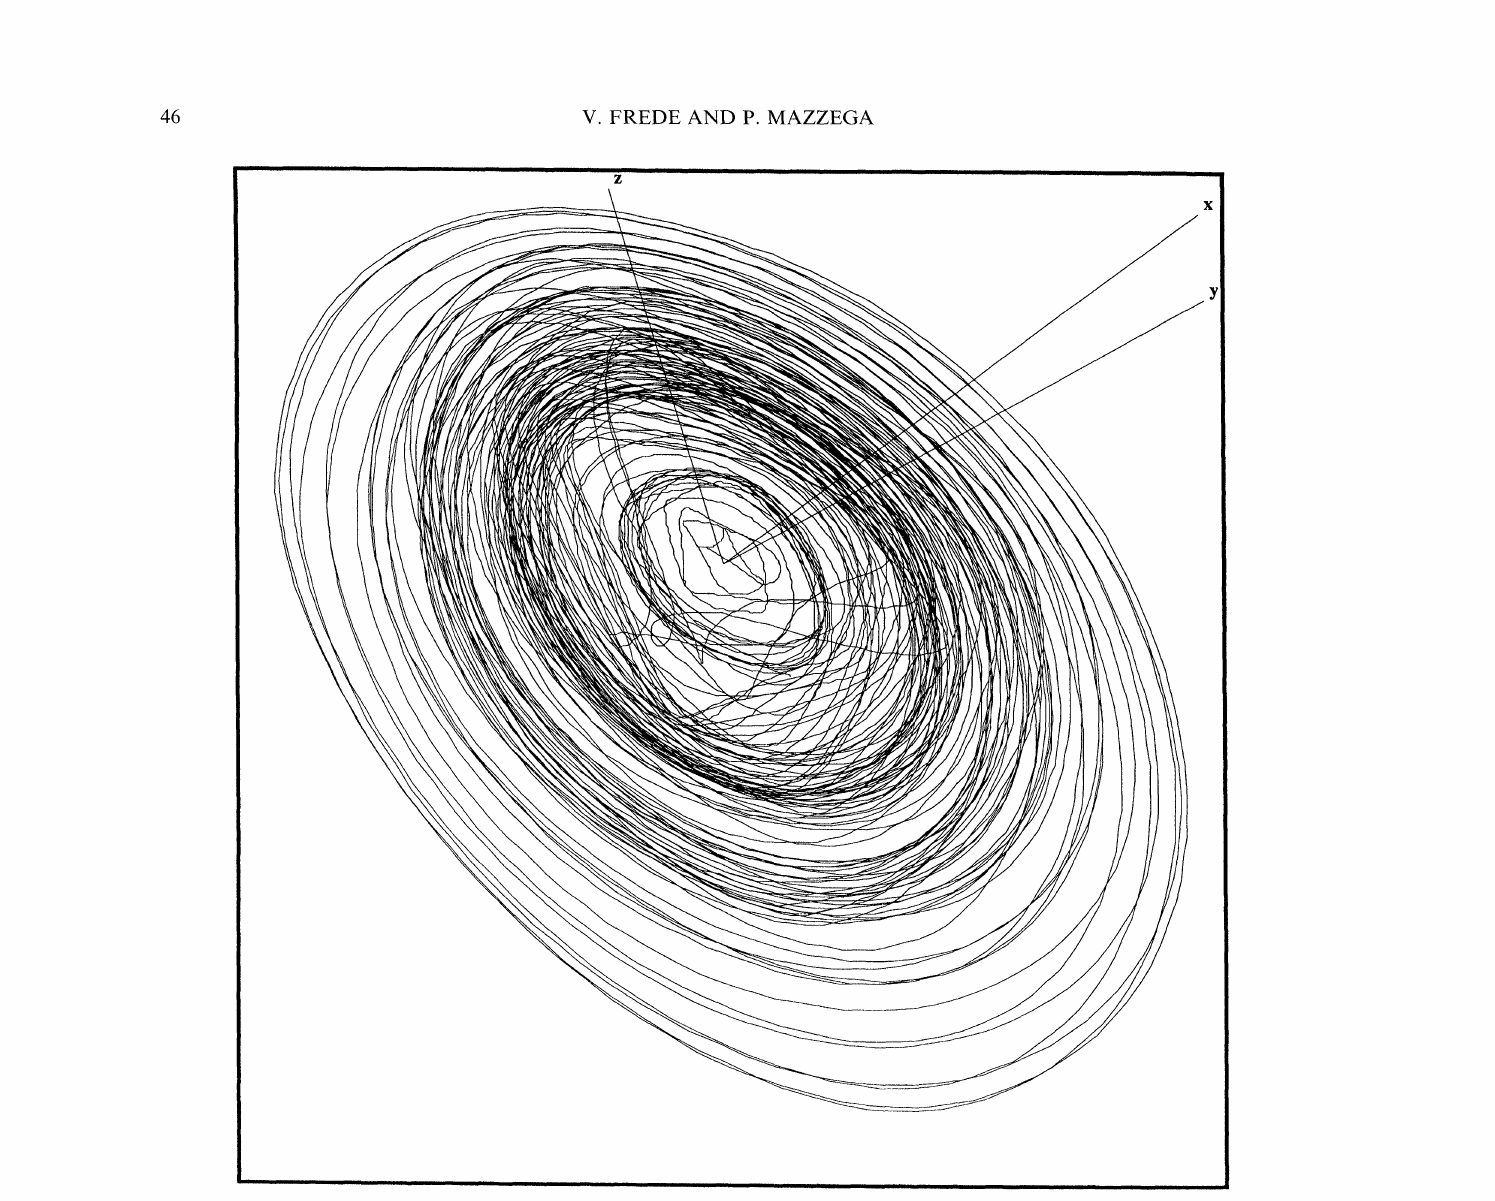
FIGURE 4 Y component of the CW reconstructed as an orbit in 4D pseudo-phase space E* (one of its 3D projection is drawn here). The delay for embedding is 115 days. The radius of the torus-like structure is about twice the data series RMS ( 100